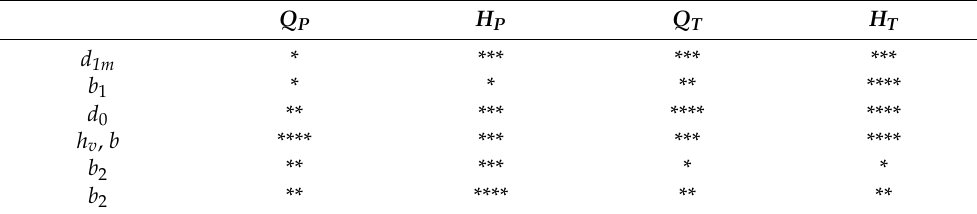
Table 7. Sensitivity to geometric